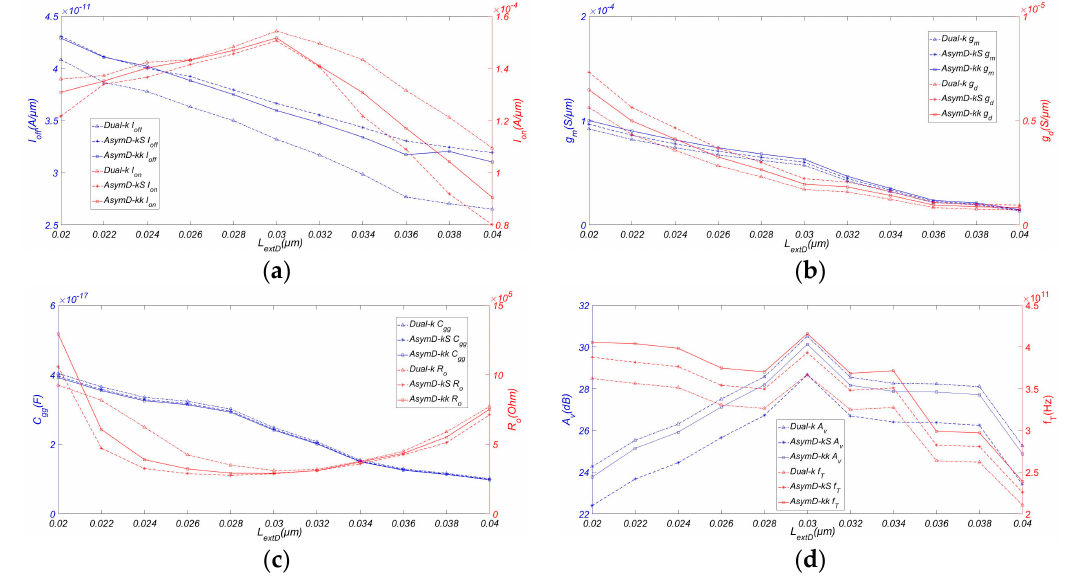
Figure 7. Variation of ( a ) I off and I on , ( b ) g m and g ds , ( c ) C gg and R o , ( d ) A v and f T of FinFET with L extD . Simulated with H fin = 15 nm, W fin = 6 nm, T ox = 0.8 nm, L ext = 20 nm, σ L = 3 nm, L hk = 12 nm, and V ds = 0.9 V.